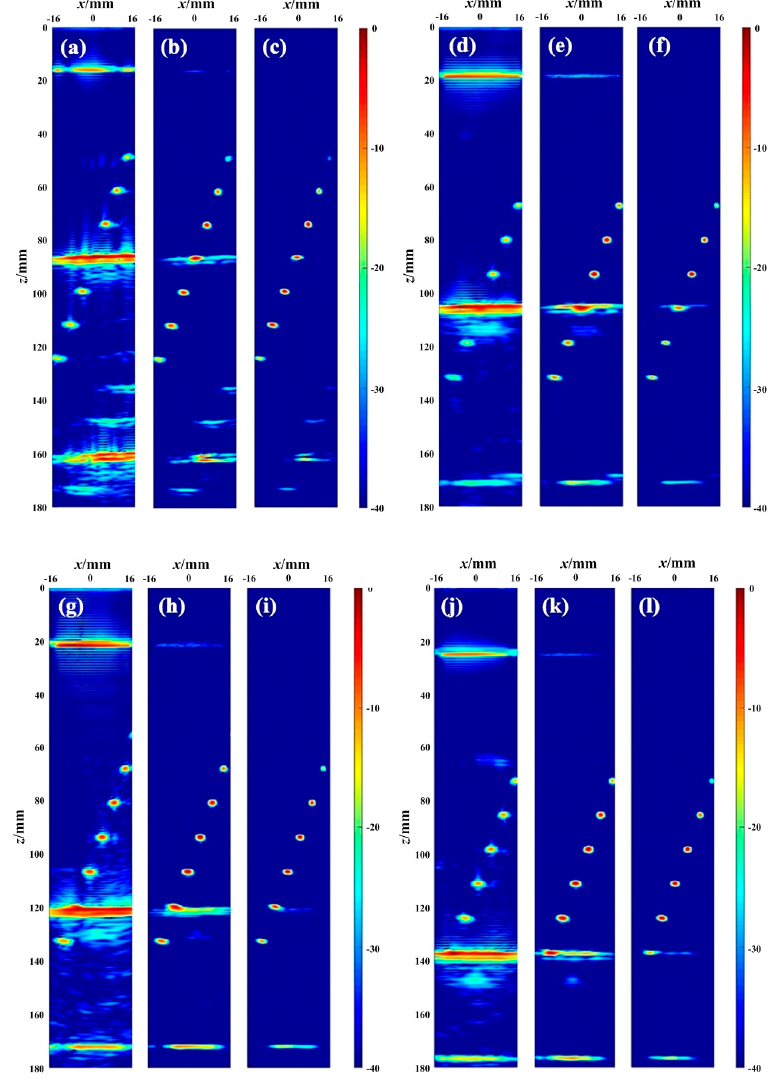
Figure 7. The image results of the different defects covered by the interface echo: ( a ) TFM; ( b ) PCSV-TFM; ( c ) PCSV-TFM with the power exponent σ = 2; of the fourth defect covered; ( d ) TFM; ( e ) PCSV-TFM; ( f ) PCSV-TFM with the power exponent σ = 2; of the fifth defect covered; ( g ) TFM; ( h ) PCSV-TFM; ( i ) PCSV-TFM with the power exponent σ = 2; of the sixth defect covered; ( j ) TFM; ( k ) PCSV-TFM; ( l ) PCSV-TFM with the power exponent σ = 2; of the seventh defect covered.